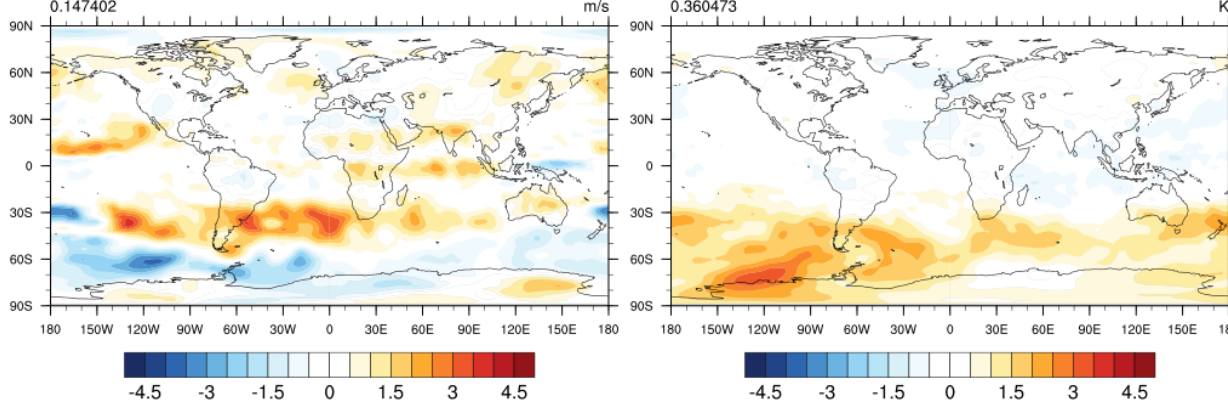
Figure 12. Same as Fig. 10 except for the vertical level of